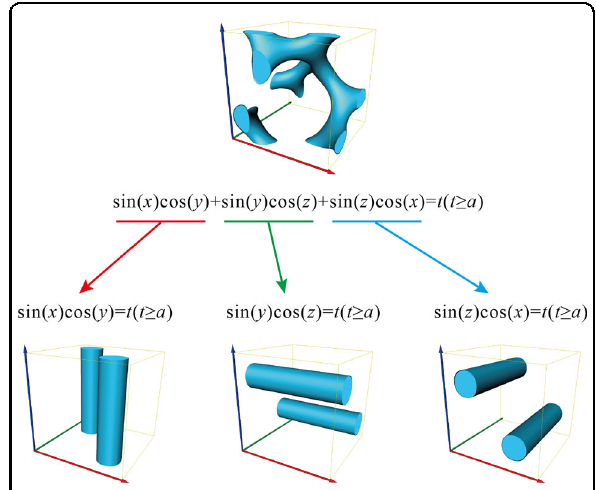
Fig. 2 Schematic diagram of the relationship between gyroid and tubular structures in terms of morphology and